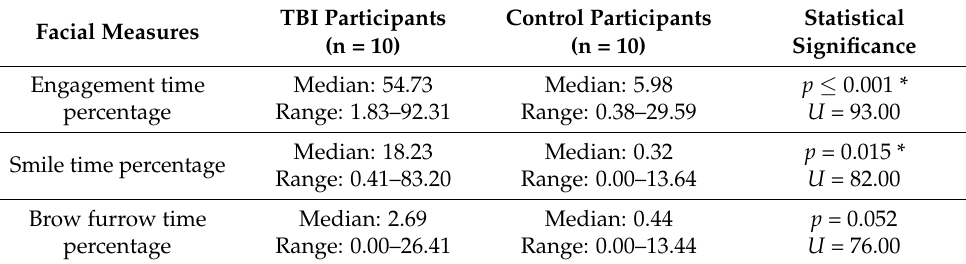
Table 7. Comparison of TBI and control participants on story narrative retell.